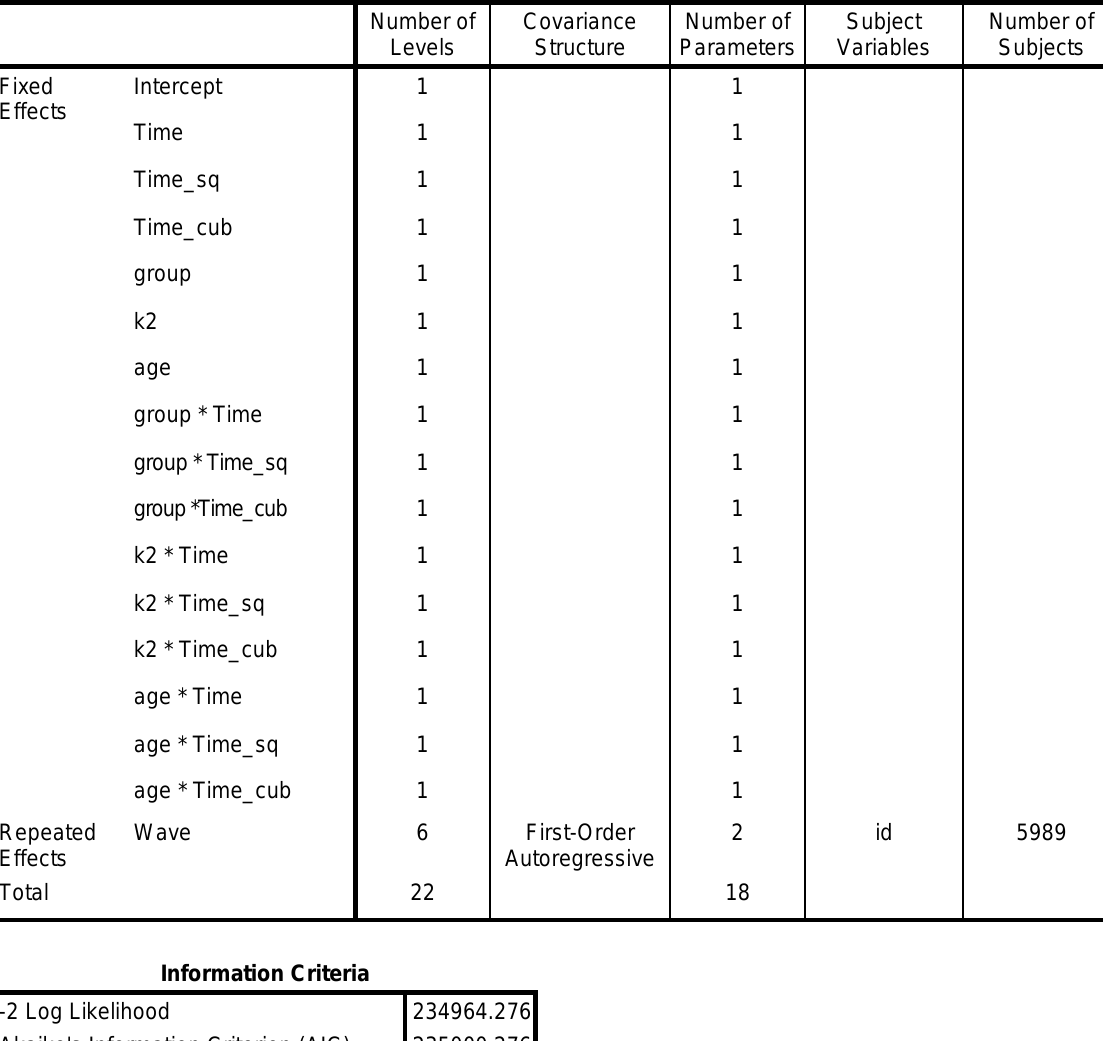
Model 8: Testing Error Structure Covariance Structure